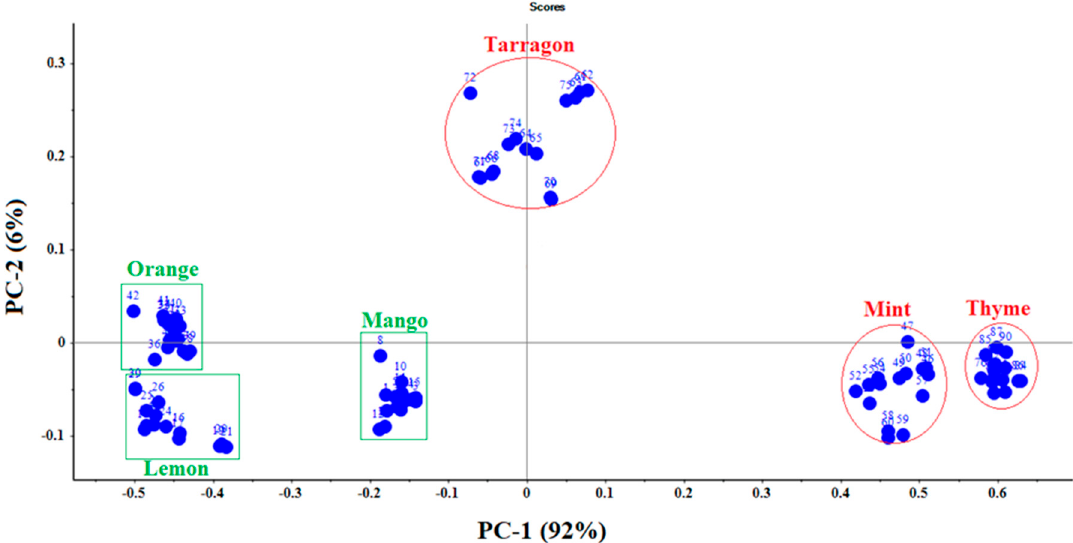
Figure 3. Two-dimensional PCA plot performed on six purified essential oils based on data collected using the MAU-9 electronic nose.